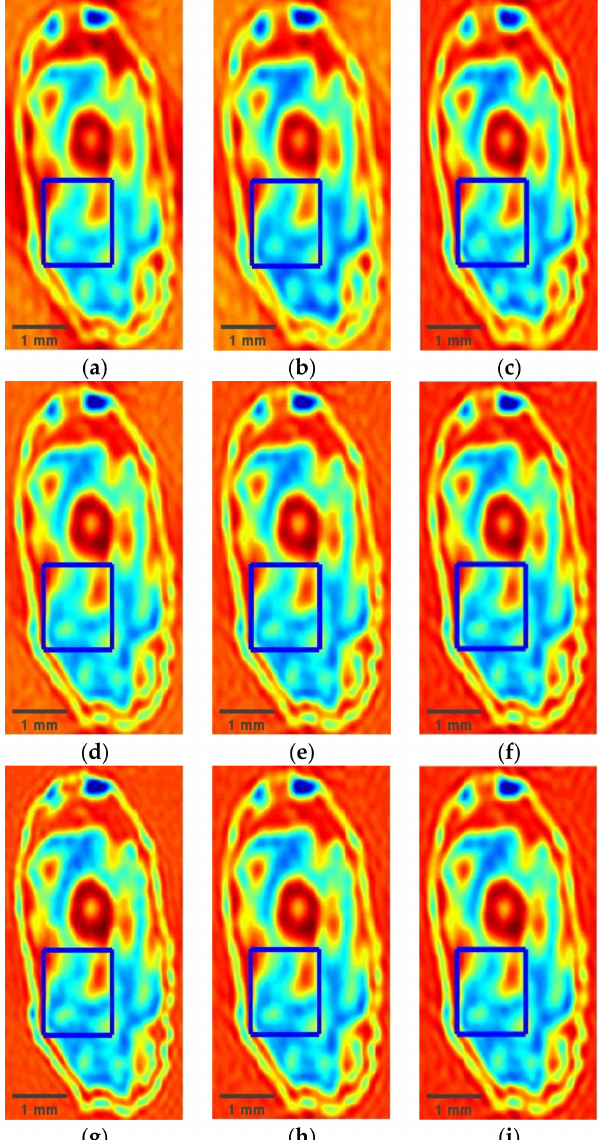
Figure 3. Reconstruction results of different methods for the wheat seed at different sampling rates.